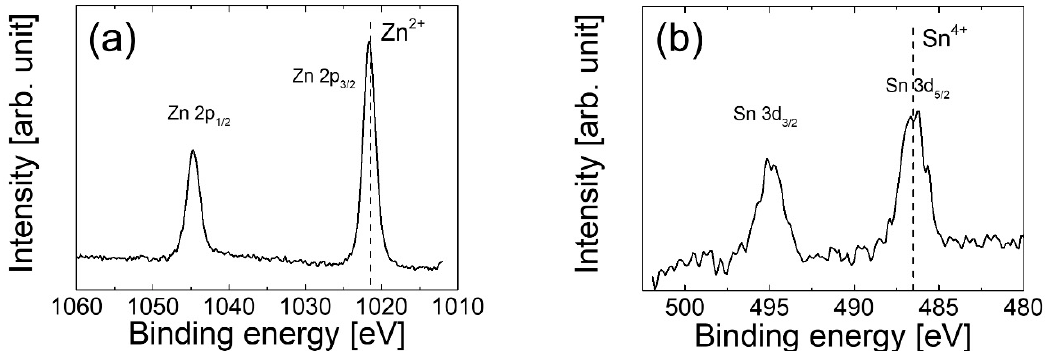
Figure 2. XPS spectra of ( a ) Zn 2p and ( b ) Sn 3d core levels in the ZnO-coated and SnO 2 -coated Bi 2 Te 2.7 Se 0.3 , respectively.